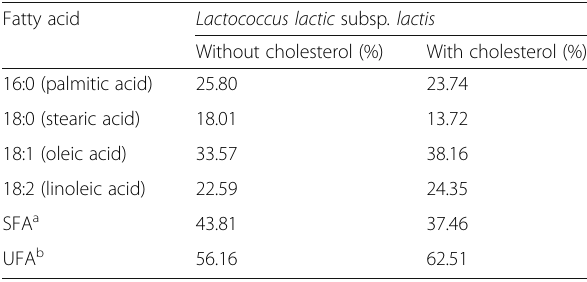
Table 3 Fatty acid composition of Lactococcus lactic subsp.